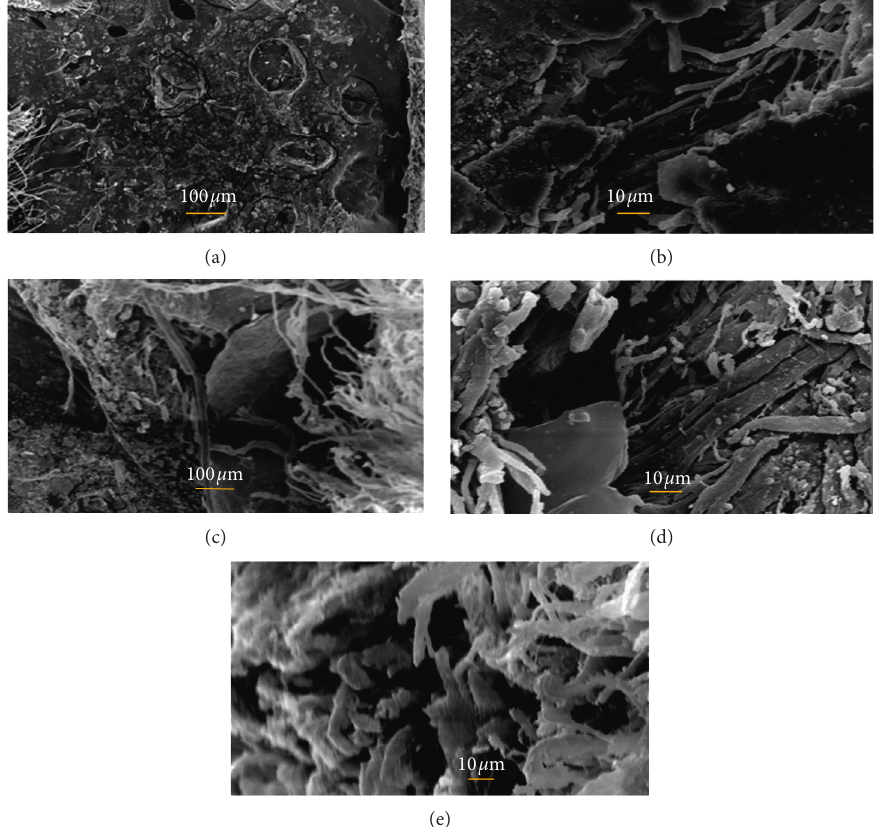
Figure 3: SEM images of leather binding. (a) The superficial appearance of the leather, which is very similar to the surface of goat leather. (b) Clear cracks in the surface of the leather. (c) Corrosion and insect holes. (d, e) Erosion of the surface layer and weakness of the leather fibers in